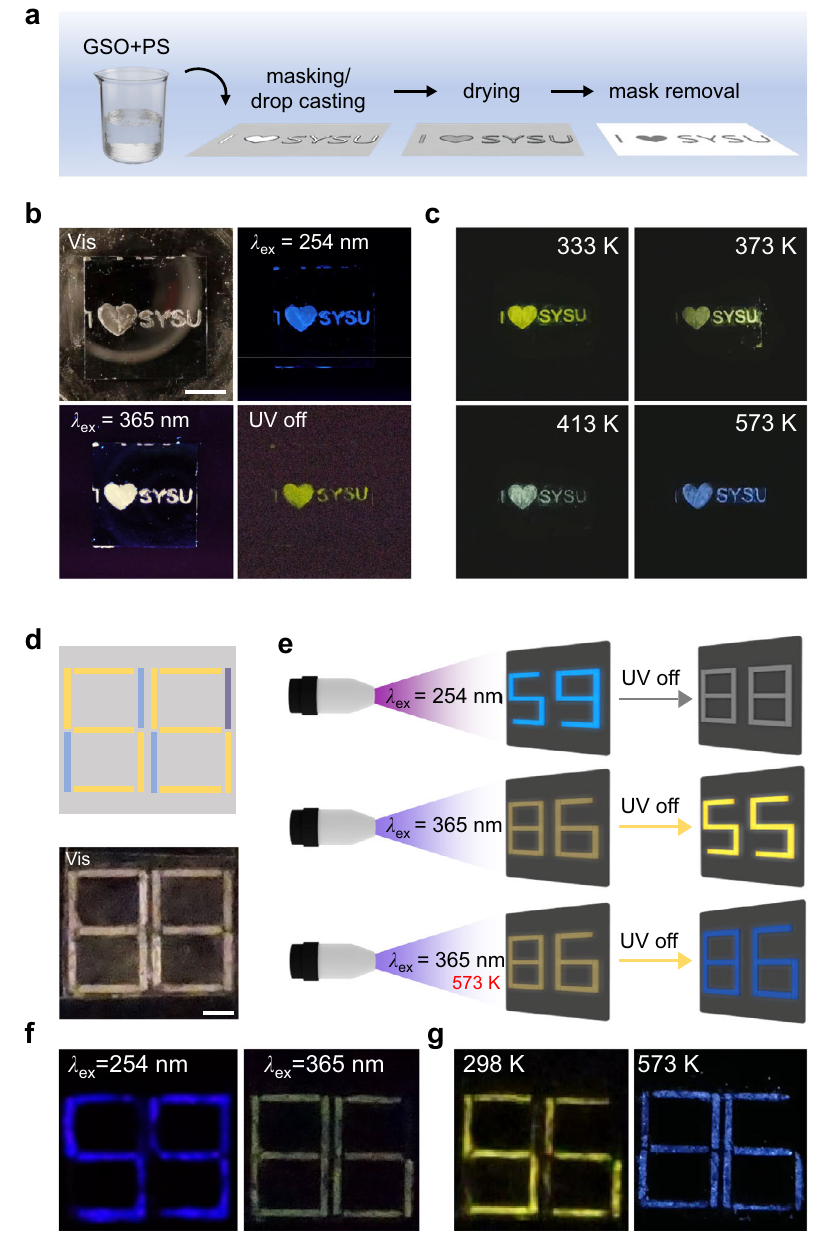
Fig. 5 | Security applications of colour-tuned GSO. a GSO patterning process by polymer encapsulation. b Anti-counterfeiting label demonstration with excitation- wavelength-dependentsecurityfeatures.PLwavelengthandlifetimefromthelabel are different using 254nm and 365nm excitation, respectively. (Scale bar = 1cm). c Temperature-responsive security demonstration. The afterglow colour of the anti-counterfeiting label is tuned by varying the temperature from 333K to 573K. Photographs were all taken 1s after the excitation ( λ ex =365nm) was switched off. d Schematic of the encryption pattern design. Different oxide-based phosphors wereselectivelydepositedonthe pre-designedpattern(blue:pristine SiO 2 ;yellow: